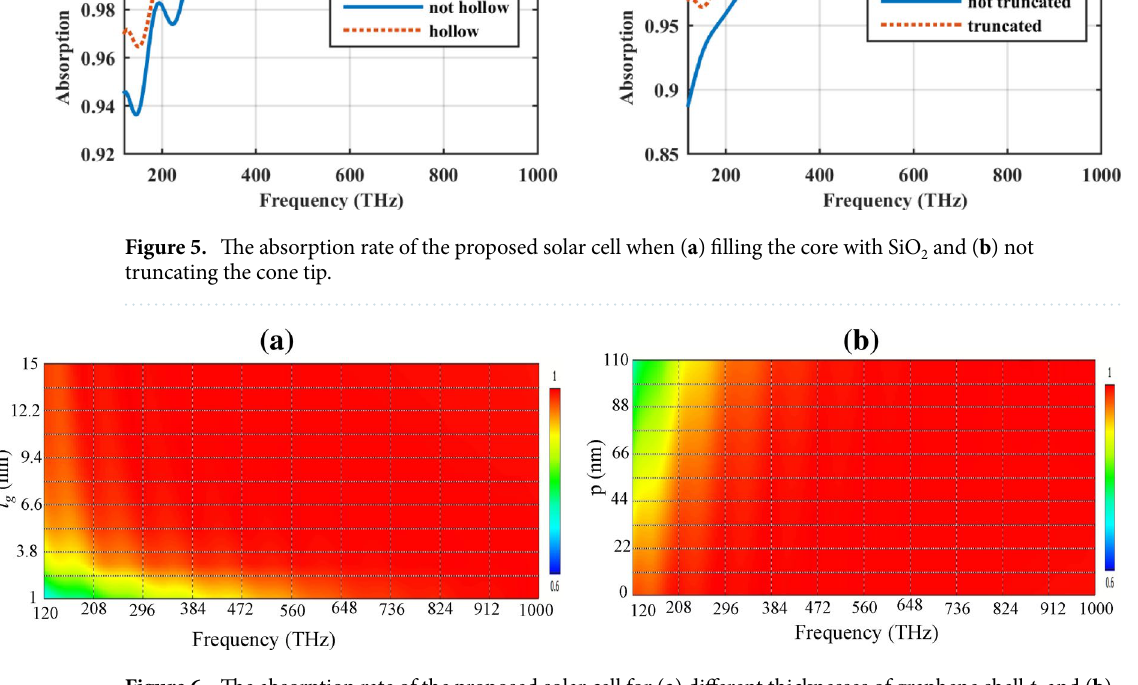
Figure 6. The absorption rate of the proposed solar cell for ( a ) different thicknesses of graphene shell t g and ( b ) the periodicity of the nano-pillars. The parameter p is the increment in the periodicity from its minimum value 2 R 1 ( T = 2R 1 + p